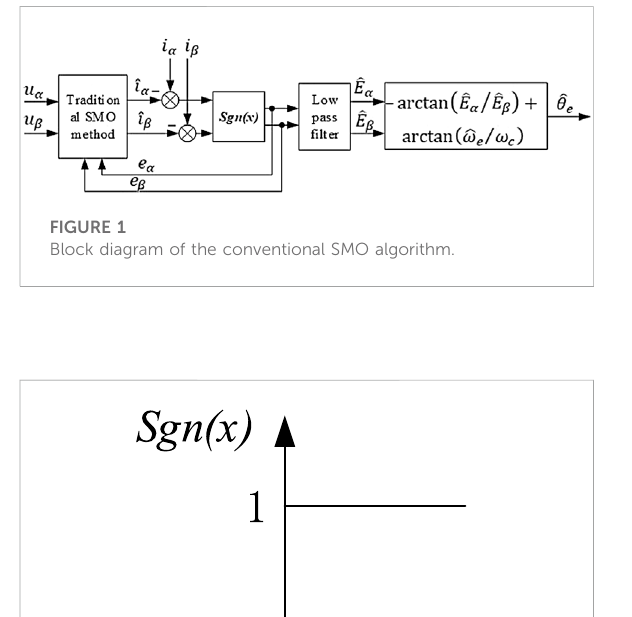
FIGURE 3 Sigmoid function curve.